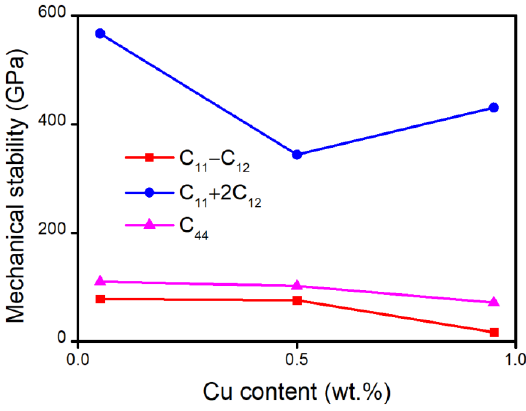
Figure 5. Mechanical stability of Cu–Ni alloys.